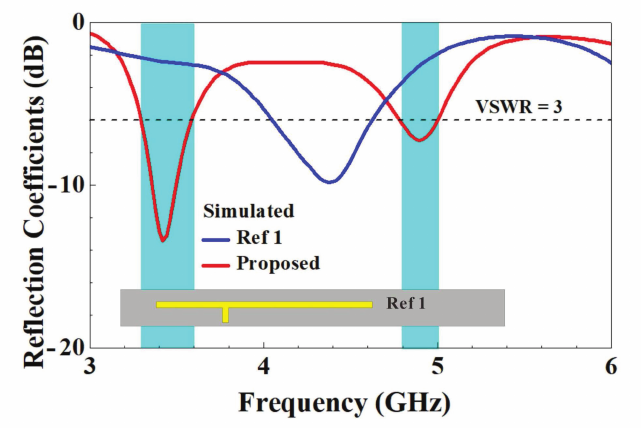
Figure 12. Comparison of the simulated reflection coefficient of a T-shaped feed-in section with and without a chip capacitance C